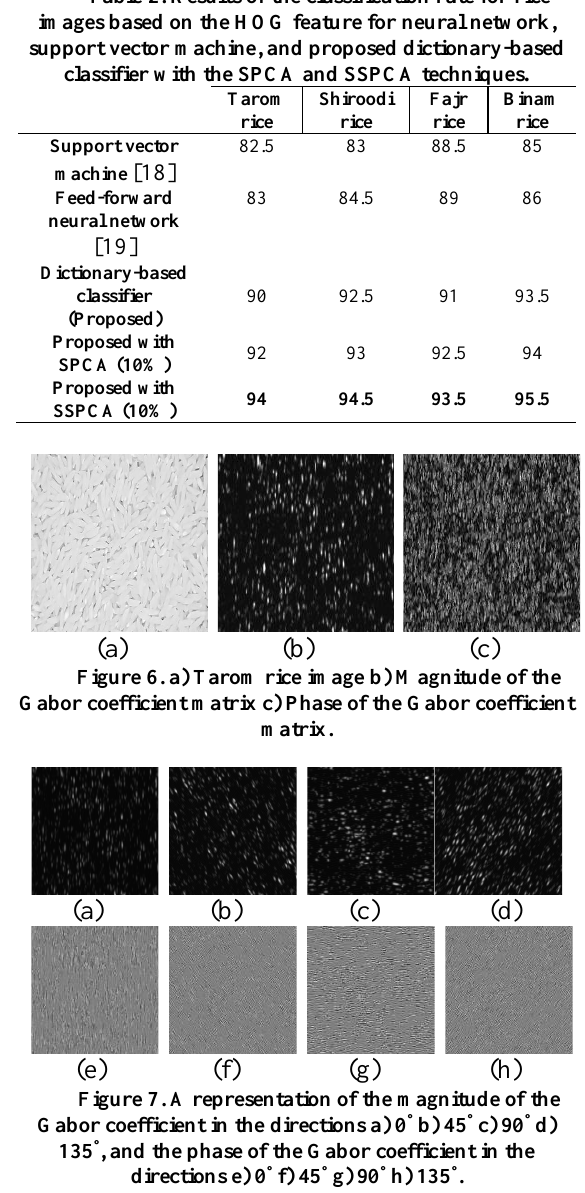
Figure 7. A representation of the magnitude of the Gabor coefficient in the directions a) 0 ° b) 45 ° c) 90 ° d) 135 ° , and the phase of the Gabor coefficient in the directions e) 0 ° f) 45 ° g) 90 ° h) 135 ° . Table 3. Results of the classification rate based on the magnitude of the Gabor features for the neural network, support vector machine, and proposed learning-based classifier with the SPCA and SSPCA techniques. Tarom Table 1. Results of the classification rate for rice images based on the HOG feature for the proposed dictionary-based classifiers using SPCA and SSPCA with different percentages of dimension reduction. Tarom Shiroodi Fajr Binam rice rice rice rice Proposed 90 92.5 91 93.5 Proposed with 86 88 89.5 SPCA (20%) Proposed with SPCA (10%) Proposed with SSPCA (10%)